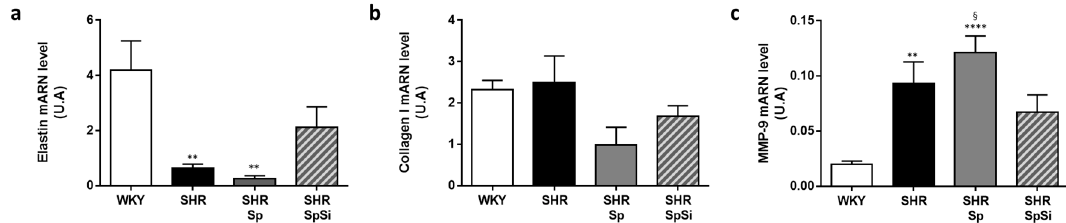
Figure 3. Effect of supplementation on aortic mRNA levels of various extracellular matrix components. The mRNA expression levels were quantified by qPCR in rat aorta for elastin ( a ), collagen I ( b ) and MMP-9 ( c ). Graphs represent mean ± s.e.m of three different determinations in each animal of all groups ( n = 15). **** p < 0.0001, ** p < 0.01 vs . WKY; § p < 0.05 vs . SpSi.